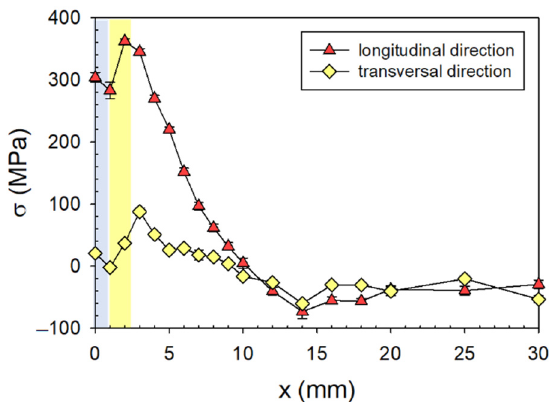
Figure 6. Residual stresses depending on the distance from the weld axis on the top side of the plate. The blue and yellow areas denote the position of the WM and HAZ, respectively.